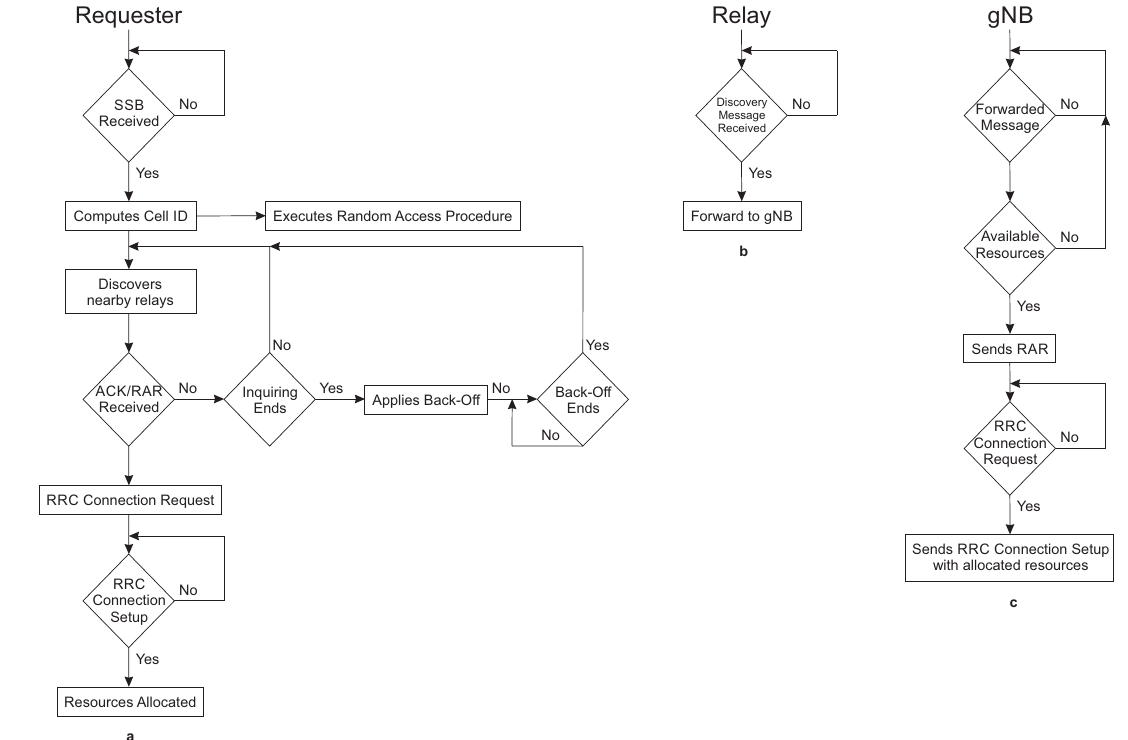
Figure 2. ( a ) Requester, ( b ) Relay, and ( c ) gNB summarized behavior